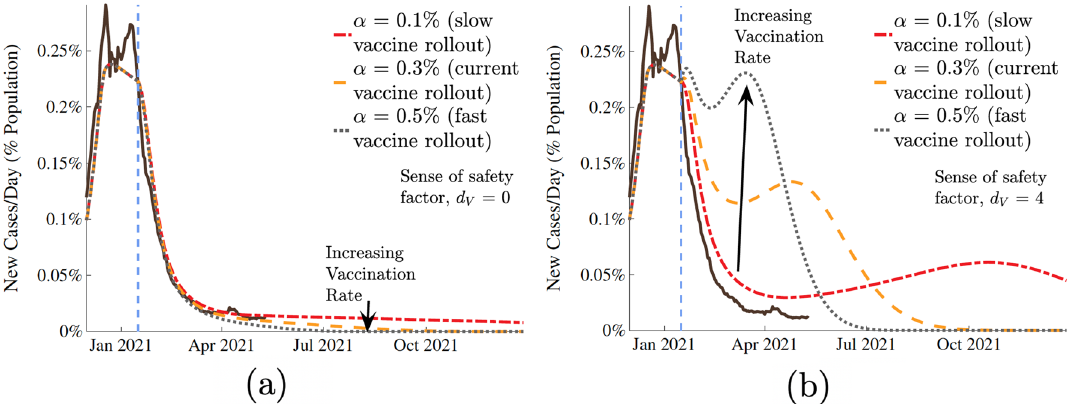
Figure 4. Impact of vaccination rate, α , with two social responses to the vaccine. The population in ( a ) shows no changes in behavior in response to the vaccine, while the population in ( b ) relaxes its preventative measures as the vaccine is